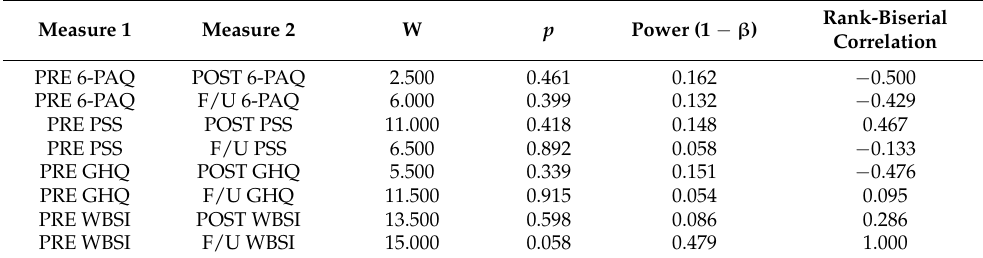
Table 4. Questionnaire scores and effect comparisons in control group.